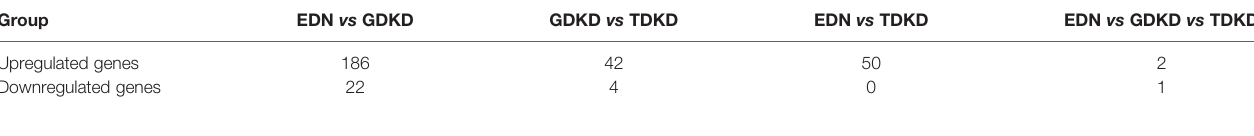
TABLE 1 | Identi fi cation of the commonly changed DEGs in the three datasets.